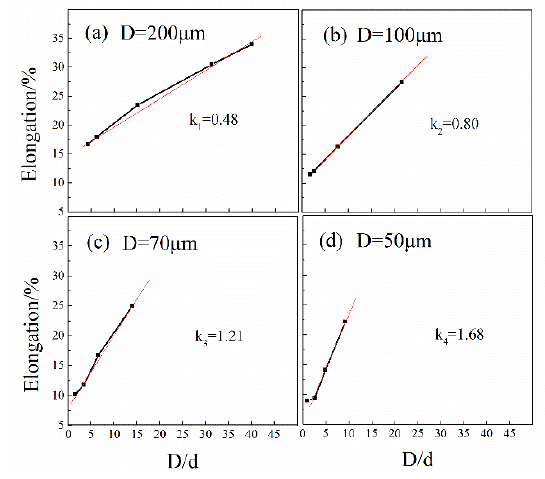
Figure 4. Tensile elongation of specimens with different size factors.